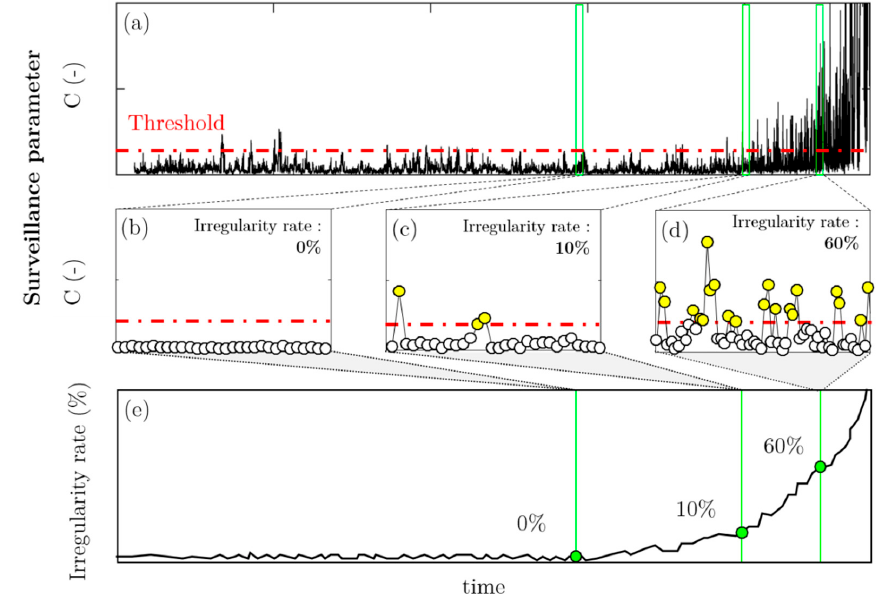
Figure 6. Schematic representation of the evolution of the surveillance parameter and the warning parameter for a given surveillance threshold. ( a ) Surveillance parameter evolution during a test; ( b – d ) zoomed views; ( e ) irregularity rate evolution.